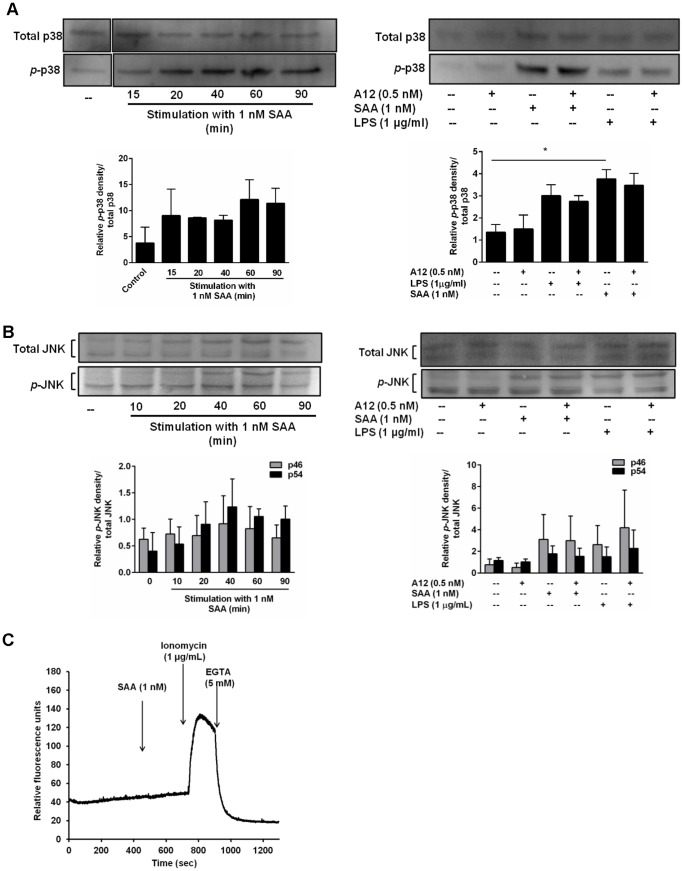
S100A12 did not alter p38 or JNK phosphorylation or provoke an intracellular Ca2+ flux.(A and B, left panels) Time course of SAA-induced p-p38 (43 kDa) and p-JNK (46 and 54 kDa) in THP-1 cells treated with SAA (1 nM) for the times indicated. (A and B, right panels) THP-1 cells treated with SAA (1 nM) ± S100A12 (0.5 nM) or LPS (1 µg/ml) ± S100A12 (0.5 nM) for 60 min. Western blotting performed with Ab against p-p38 (Thr180/Tyr182) MAPK and active JNK. Anti-p38 (Thr180/Tyr182) MAPK and anti-SAPK/JNK Ab were used as controls for protein loading. Western blots shown are representative of two or three separate experiments. Blots in (A) were cropped to highlight relevant treatments for the study. (A and B, bottom panels) Intensities of bands corresponding to p-p38 (43 kDa) and p-JNK (46 and 54 kDa) were quantified by densitometry, and expressed as means ± SEM from two or three separate experiments, respectively; *p<0.05 compared to unstimulated cells (analyzed by one-way ANOVA with Bonferroni’s correction for multiple comparison tests). (C) THP-1 cells pre-incubated with Fluo-3 acetoxymethyl ester for 1 h were stimulated with SAA (1 nM) and [Ca2+]i measured. Ionomycin (1 µg/ml) was positive control; EGTA (5 mM), a Ca2+ chelator (negative control) was added to confirm Ca2+ involvement. Results from a single experiment, representative of two separate experiments, are shown.